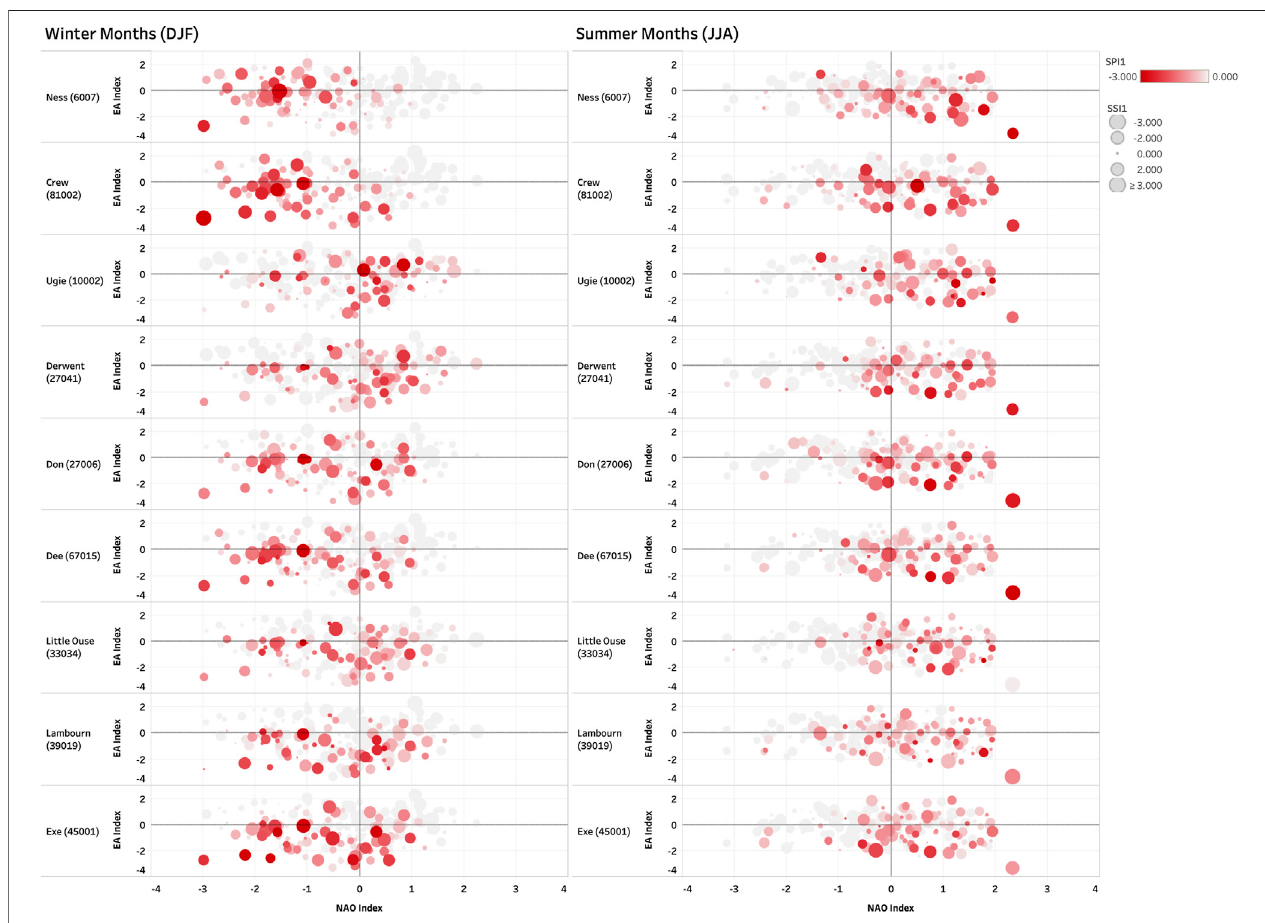
FIGURE 8 | Seasonal teleconnection index plots for winter (DJF) and summer (JJA). The points are coloured by the catchment SPI-1 value, whilst the size represents the SSI-1 value. Large red points indicate both meteorological and hydrological drought, whilst a small red point suggests meteorological, but not hydrological, drought.